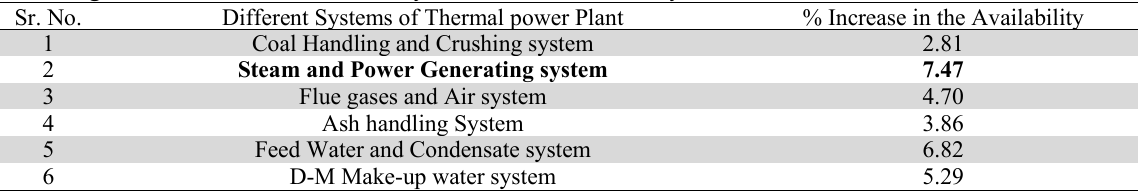
Percentage increase in the Availability values for different systems of a Thermal Power Plant Sr. No.